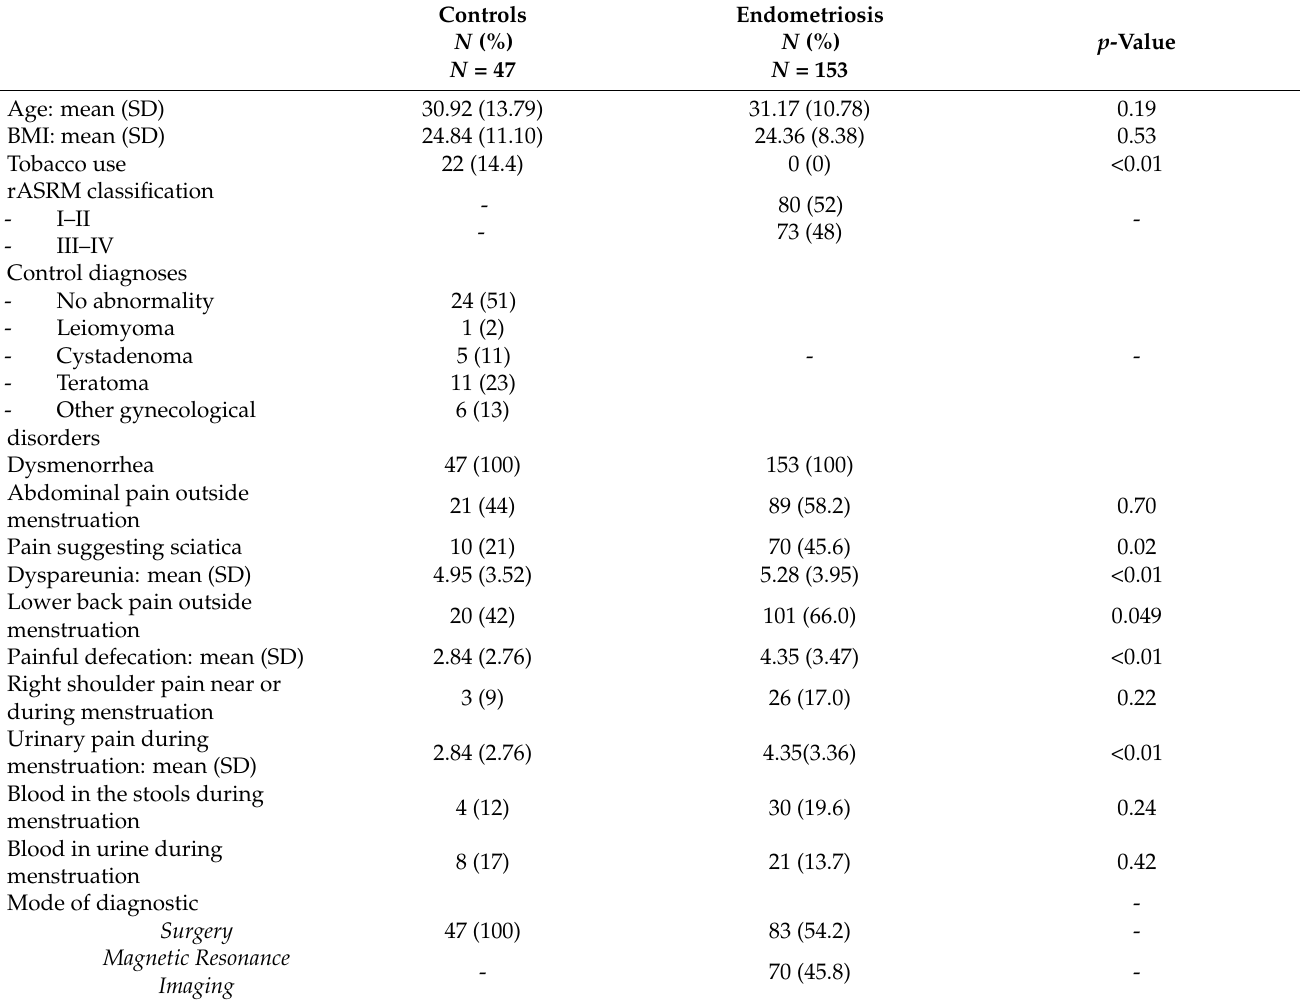
Table 1. Demographic characteristics of the patients included in the ENDOmiRNA